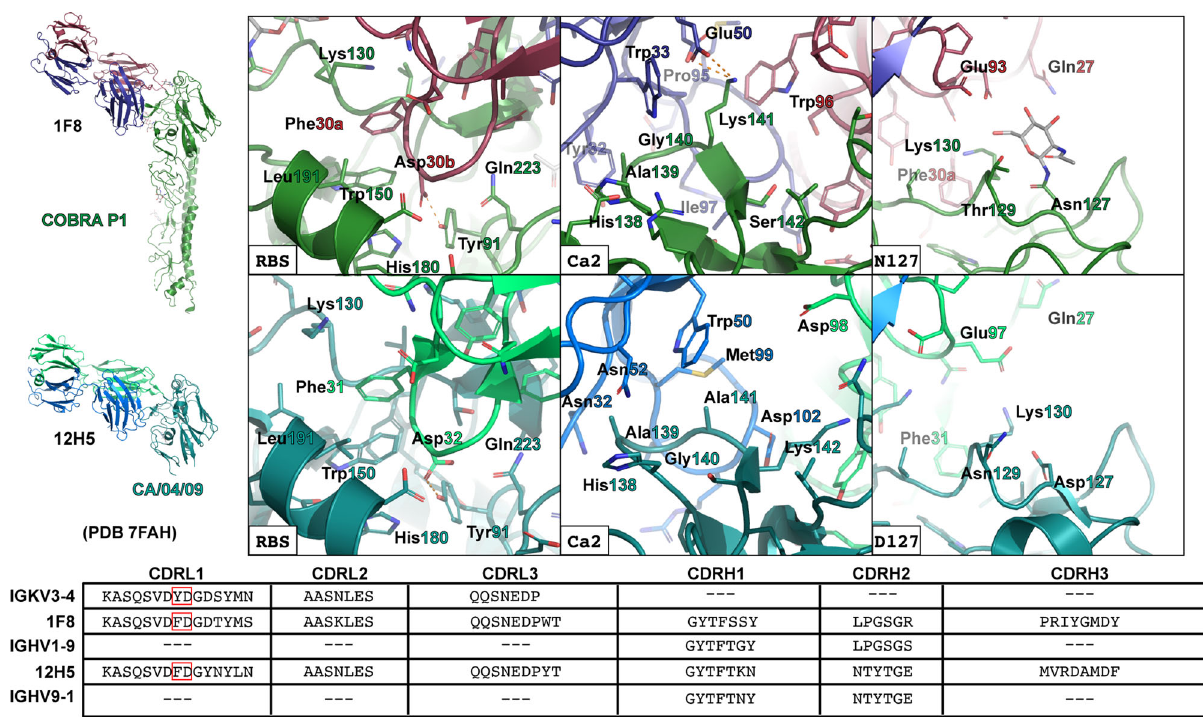
Fig. 8 Comparison of 1F8 and 12H5 binding characteristics. The P1-1F8 and CA/04/09-12H5 (PDB entry 7FAH) structures were aligned based on the secondary structure structural alignment of the HA head domains. Overall structural representations are presented as cartoons of a monomeric HA bound to the Fab version of the antibody. Closeup views of the binding interfaces in the RBS, Ca2 antigenic site, and the region near residue 127 regions are depicted, with electrostatic interactions depicted by orange dashes. Comparisons of the CDR regions in germline antibody lineages versus antibodies 1F8 and 12H5 are